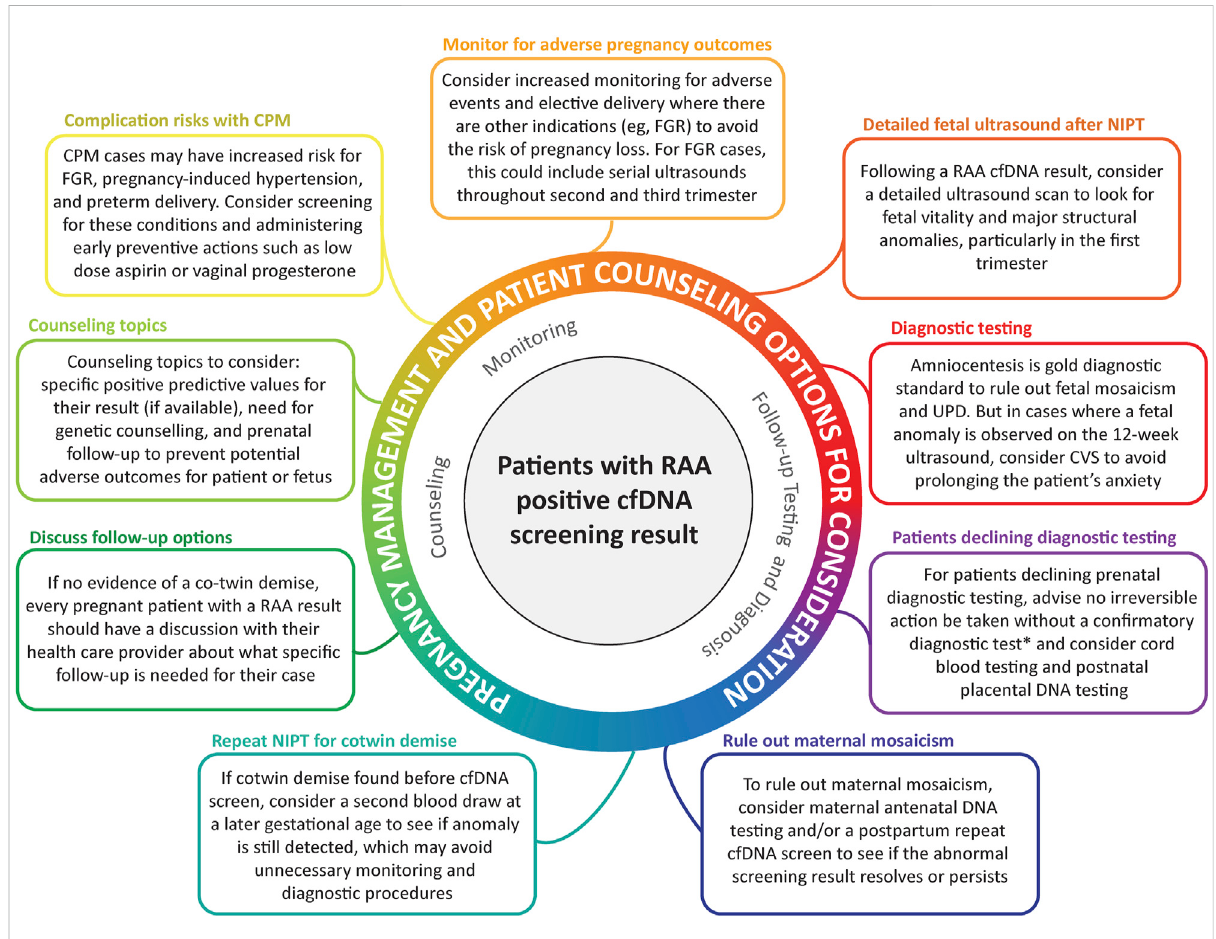
FIGURE 6 Pregnancymanagementandpatientcounsellingoptionsforconsideration.*NIPTisascreeningtest.Noirreversibleclinicaldecisionsshouldbe made based on these screening results